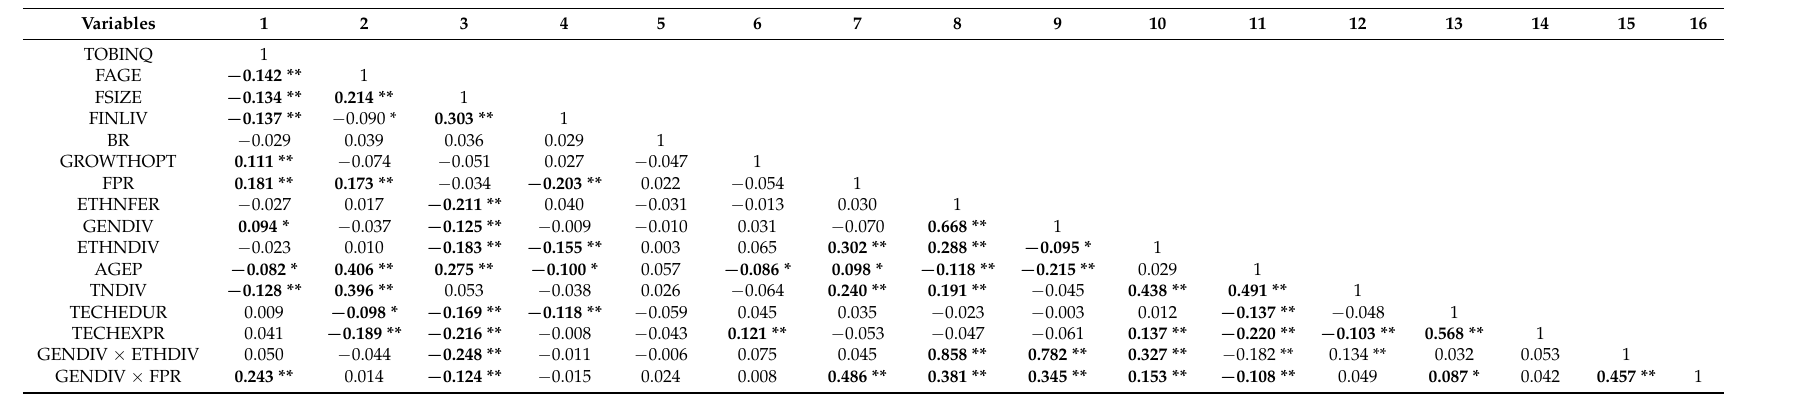
Table 3. Correlation matrix (125